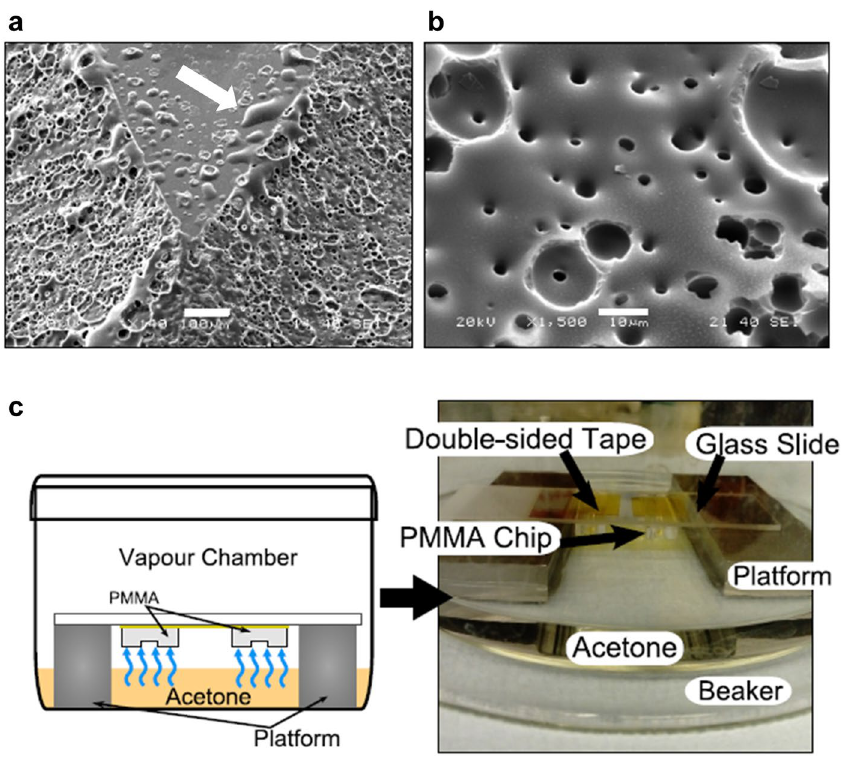
Figure 3. Surface Roughness and treatment setup. ( a ) Surface defects appearing on an engraved flow splitter. Material residue from the ablation process deposits on flat surfaces (white arrow) and can cause leaking. Scale bar: 100 μ m. ( b ) Detail of the microcavities and pores formed during ablation of the surface of the channel. Scale bar: 10 μ m. ( c ) Acetone vapour treatment chamber setup. The engraved PPMA channels are exposed to the acetone vapour as it evaporates from a reservoir, while a metal platform prevents direct contact with the liquid